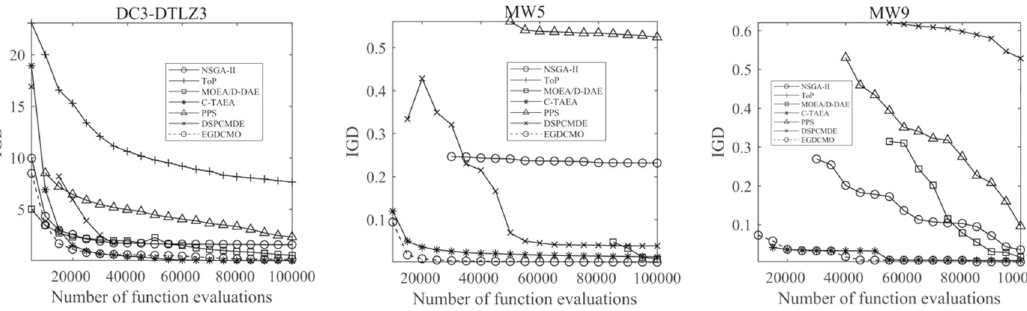
Fig. 14 Convergence profiles of IGD values obtained by the proposed EGDCMO and all the compared CMOEAs on DC3-DTLZ3, MW5, and MW9, averaged over 30